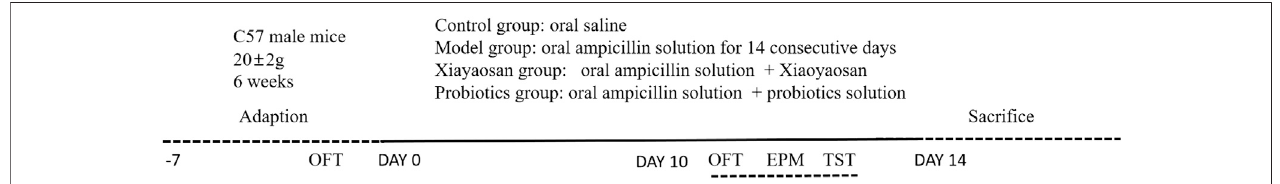
FIGURE 1 | Experimental fl owchart. Mice were divided into four groups: the control group, model group, Xiaoyaosan treatment group, and probiotics treatment group. The model group received oral ampicillin solution for 14 consecutive days at a dose of 100 mg/kg and an intragastric volume of 0.1 ml/10 g body weight. The control group received oral saline in an equivalent volume and served as a negative control. Mice in the two treatment groups received Xiaoyaosan (0.658 g/kg/d) and probiotics solution (0.15 ml/d),